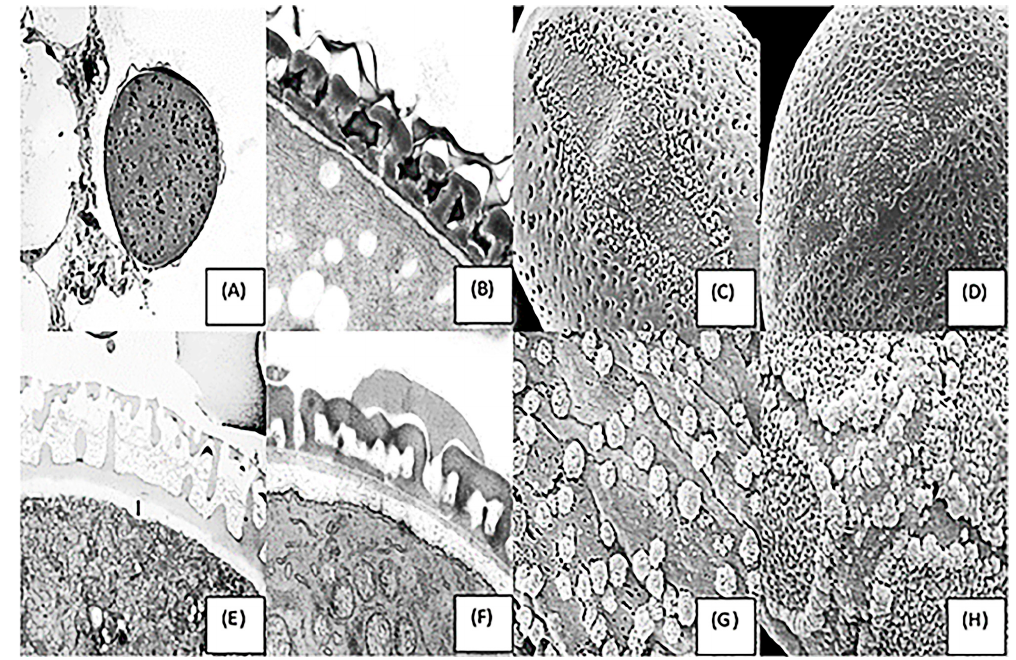
Figure 7. TEM micrographs: ( A , B ) A. reptans , ( C ) A. aucheri , ( D ) A. orientalis , ( E ) C. reticulatus subsp. reticulatus , ( F ) L. kurdica subsp. kurdica , and ( G , H ) R. caespitosa .